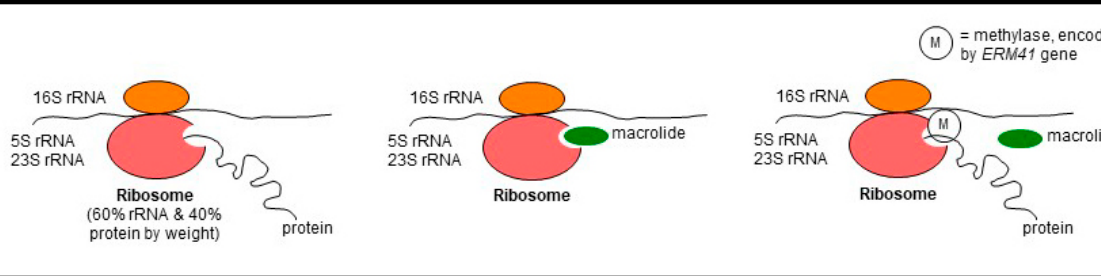
Figure 4. Mechanism of inducible resistance in M. abscessus . In M. abscessus sensu stricto and M. bolletii , macrolide binds to 23S rRNA and inhibits bacterial protein synthesis. With induction of methylase production by clarithromycin, the methylase prevents the binding of macrolide, creating an inducible resistance. Since clarithromycin induction of the ERM41 gene to produce methylase is much greater than by azithromycin, clarithromycin is much more likely to induce macrolide resistance than azithromycin.